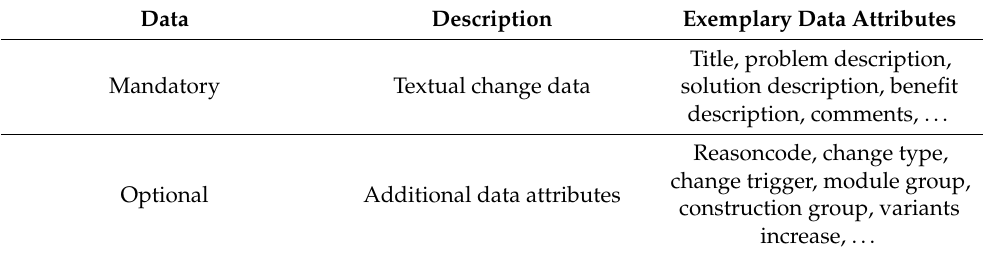
Table 2. Overview of collected data in